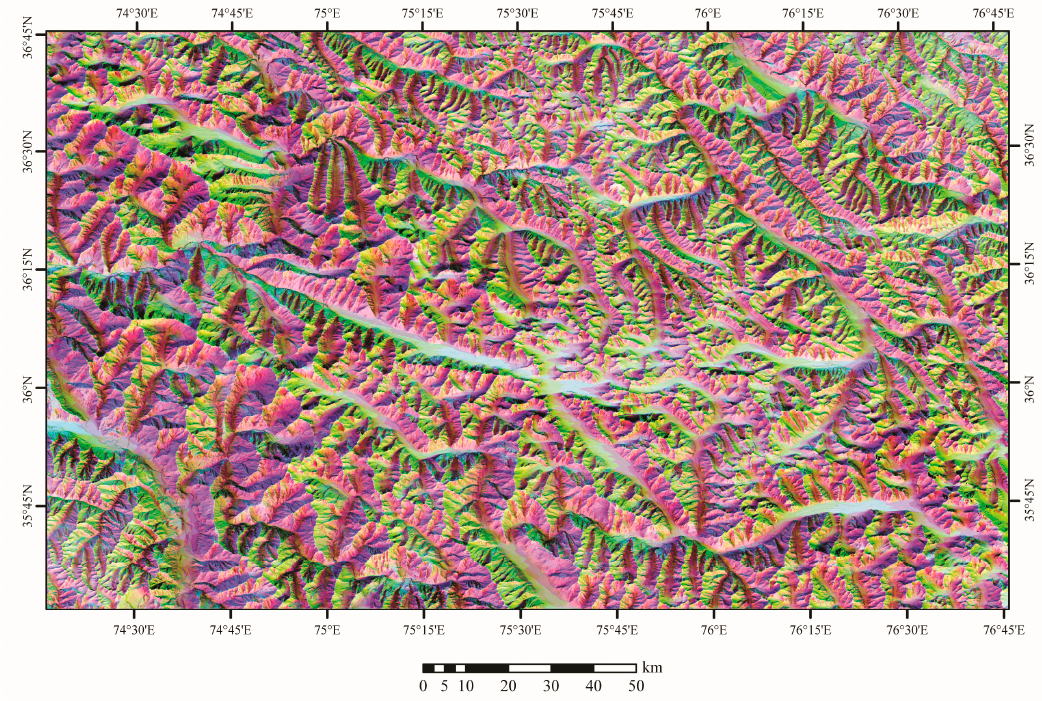
Figure 4. False-color composite image of information generated from a diurnal simulation of direct irradiance on 15 August 2013 over the Central Karakoram using the Spectral Topographic Solar Radiation Model (STSRM) version 1 developed by the authors [110]. Total diurnal energy is depicted by red, while the degree of morning shadowing is depicted by green, and the degree of evening shadowing depicted by blue. Light-tone colors signify more irradiance and less topographic effects, while darker colors depict less surface irradiance and more topographic shielding.